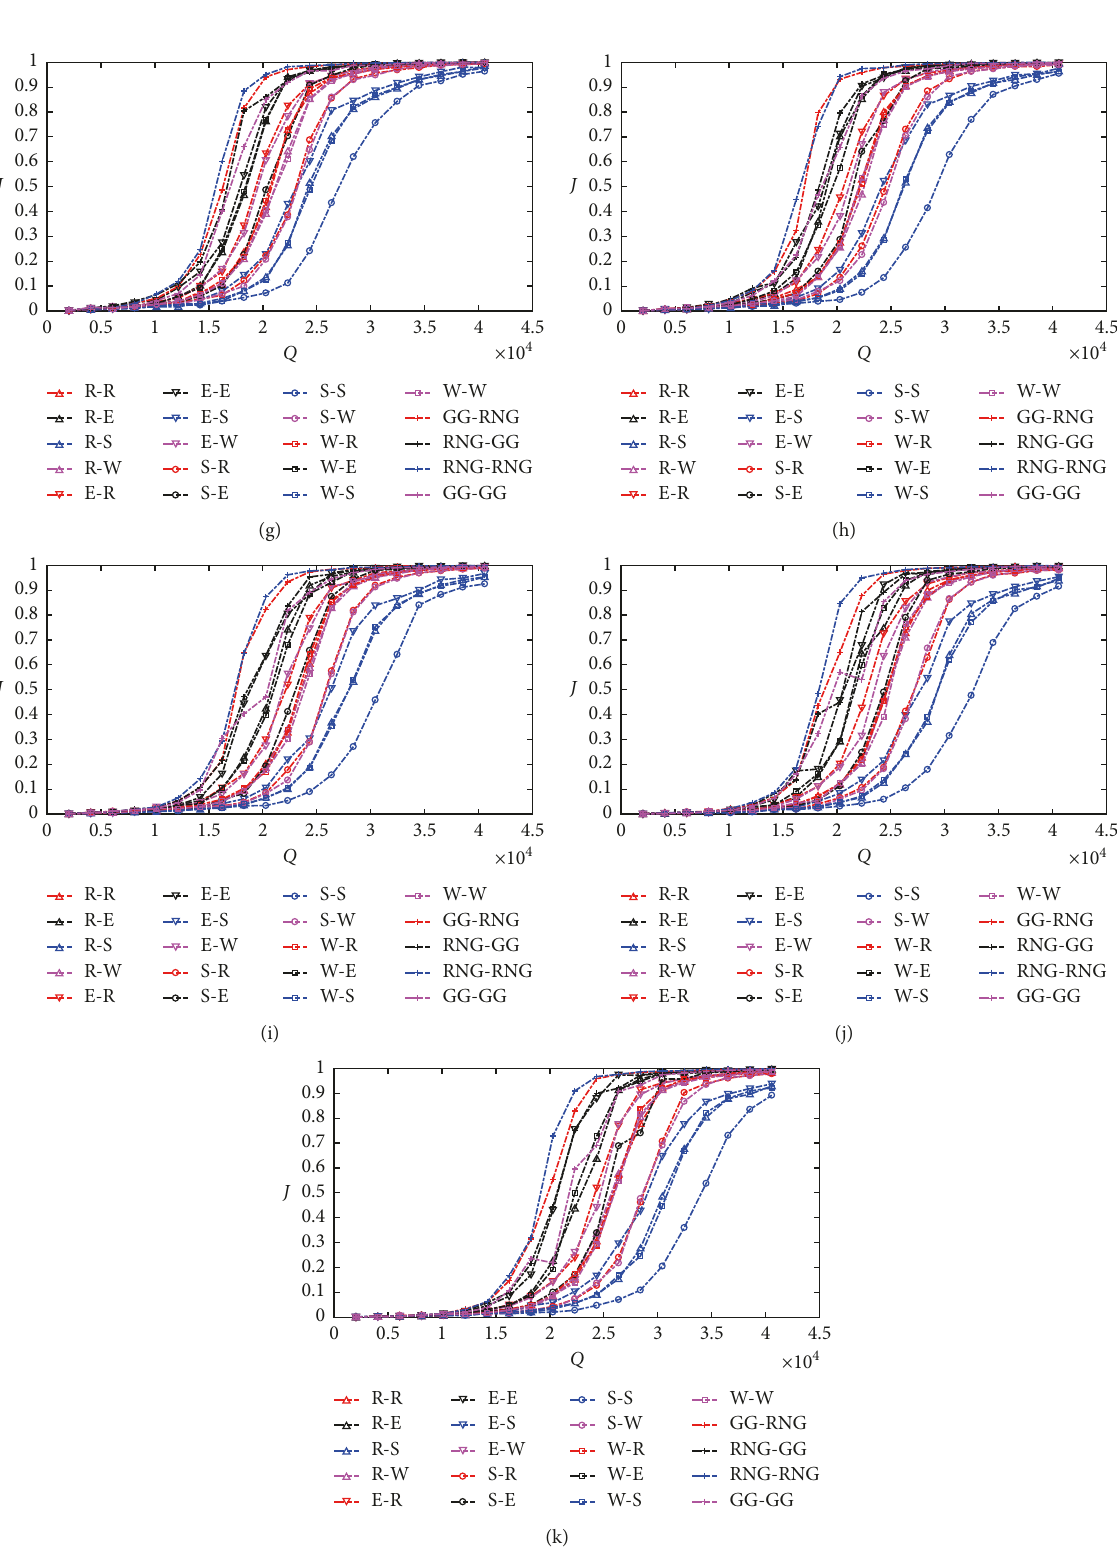
Figure 12: The influence of tunable parameter τ on multilayer networks (with the same number of nodes) when the networks are completely connected. (a) τ � 1. (b) τ � 1 . 1. (c) τ � 1 . 2. (d) τ � 1 . 3. (e) τ � 1 . 4. (f) τ � 1 . 5. (g) τ � 1 . 6. (h) τ � 1 . 7. (i) τ � 1 . 8. (j) τ � 1 . 9. (k) τ �